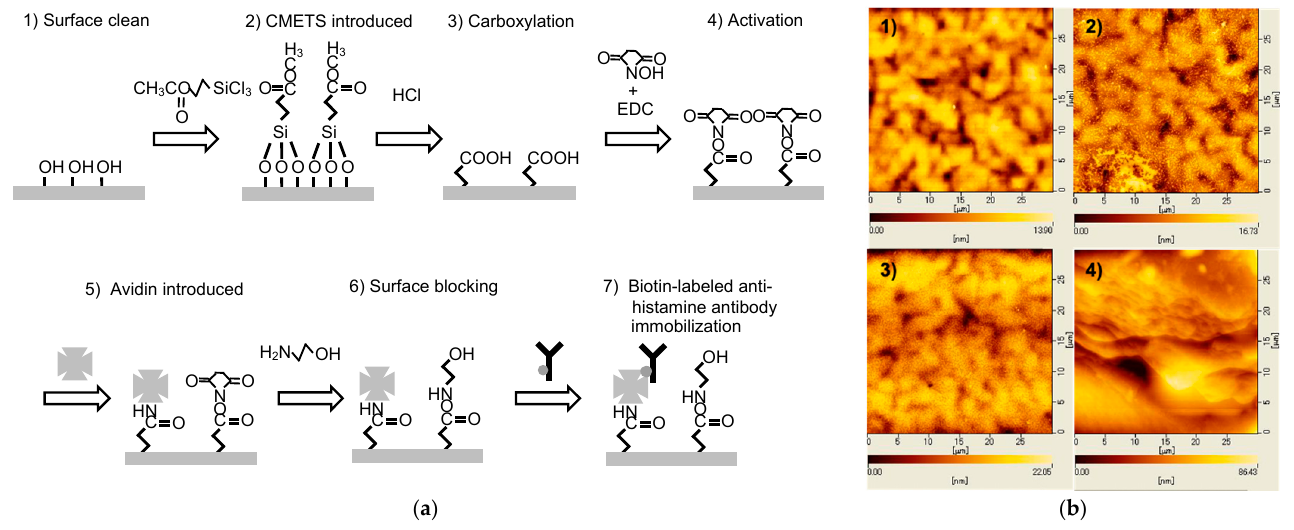
Figure 6. ( a ) procedure of surface modification on the sensing plate. ( 1 ) Suefce clean with acetone and ethanol. ( 2 ) The sensing plate was incubaed in a 0.5 mM 2-carbomethoxy ethyltrichlorosilane (CMETS) solution of CMETS in toluene at − 15 °C for 1 h to procude the ester group. ( 3 ) The ester group was carboxylated by immersing the sensing plate in 35% HCl at room temperature for 24 h. ( 4 ) N-hydroxysuccinimide (NHS) and 1-ethyl-3-(3-dimethrlaminopropyl)-carbodimide hydrochloride (EDC) in phosphate-buffered saline (PBS) were dissolved in 3 mM and 1 mM, respectively, and the carboxyl group was activated by immersing the sensing plate in an NHS & EDC solution pre- pared at pH 7.4 for 30 min at room temperature. ( 5 ) The sensing plate was anchored on a measuring substrate. Avidin was diluted to 0.147 μ M with PBS and 30 μ L was poured into each well for im- mobilization at 4 °C for 24 h. ( 6 ) The surface was blocked by 1mM 2-Aminoethanol at room temper-